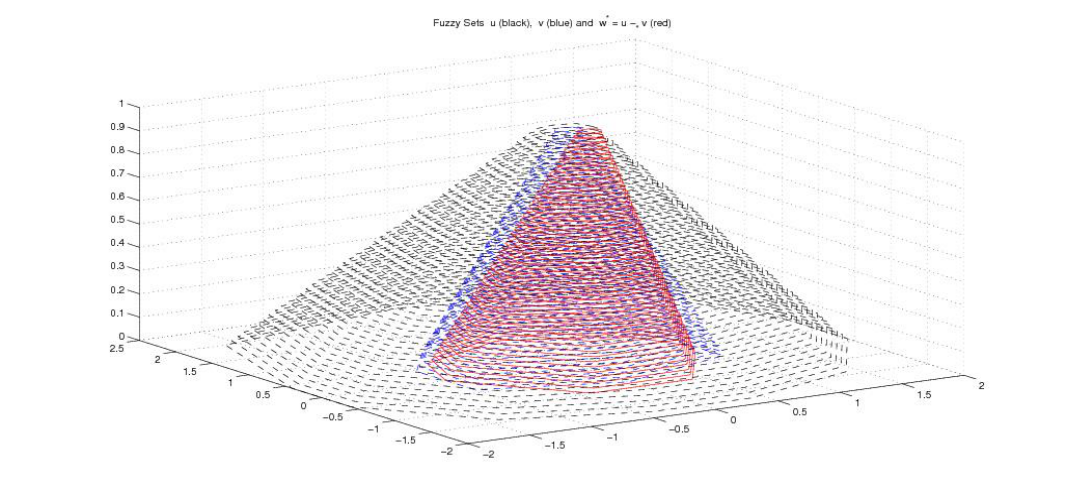
Figure 6. Fuzzy Example 2. Fuzzy sets u (black), v (blue) and fuzzy ct-difference w ∗ = u (cid:9) ct v